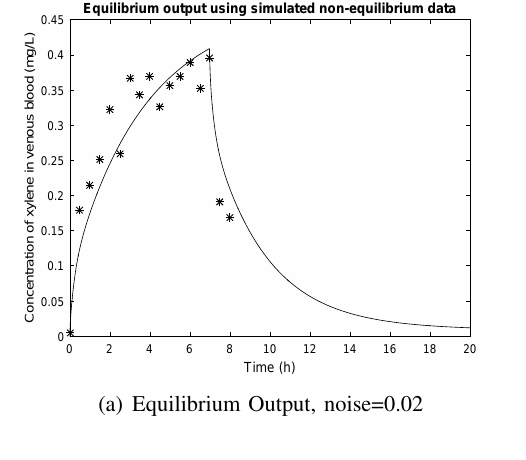
(b) Equilibrium Output, noise=0.05